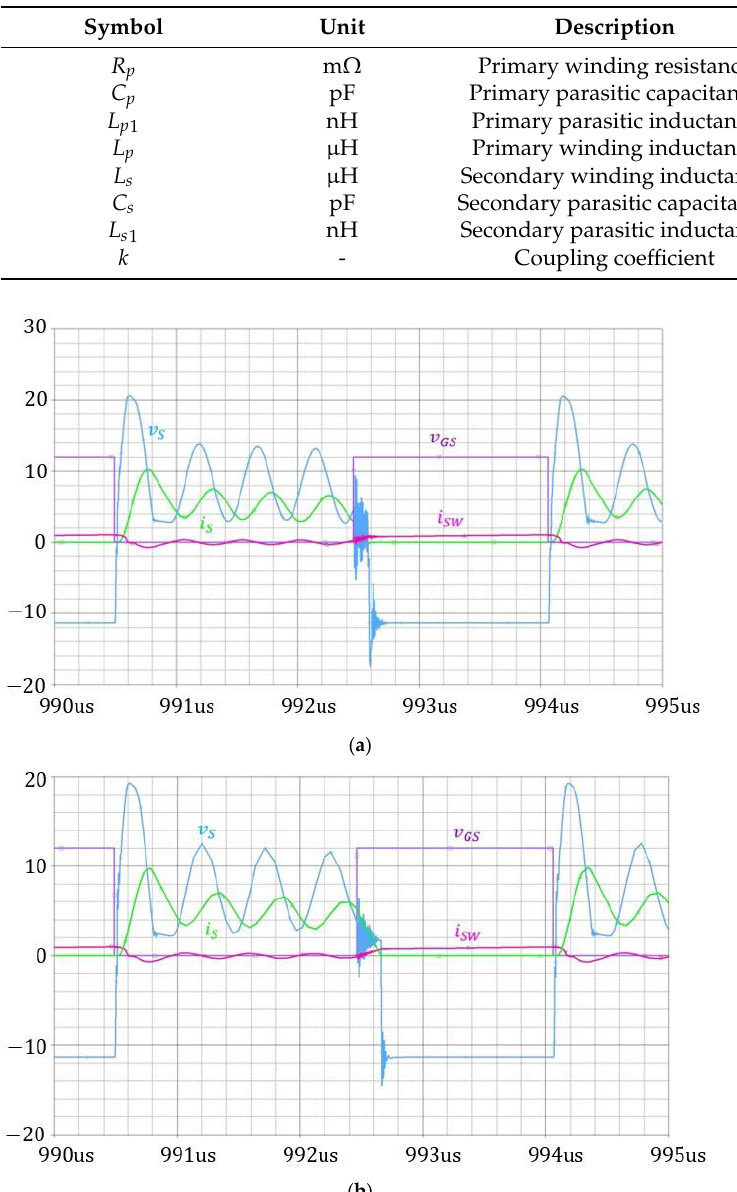
Figure 8. SPICE Simulation. Figure 9. Flyback Transformer equivalent circuit used in SPICE Simulation. Figure 9. Flyback Transformer equivalent circuit used in SPICE Simulation. Table 8. Transformer parameters in SPICE Simulation.